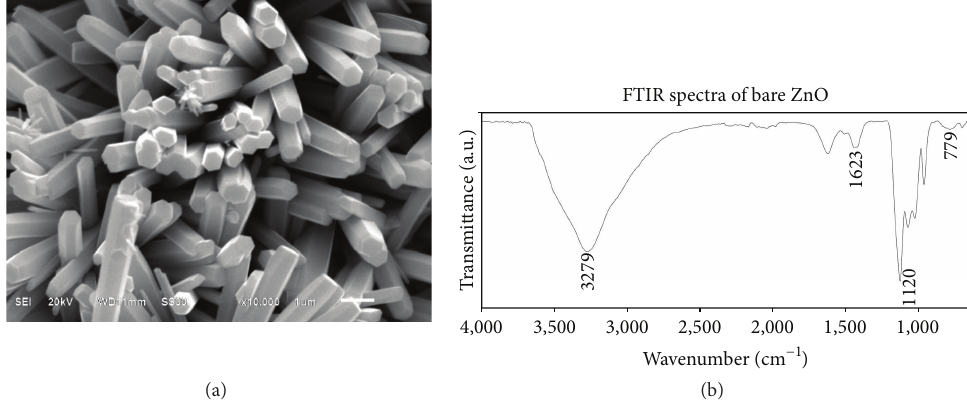
Figure 1: (a) SEM image of as-grown bare ZnO on glass substrate using 0.03 M ZnSO 4 and 1.0M NH 4 OH showing hexagonal rods and (b) corresponding FTIR spectra.